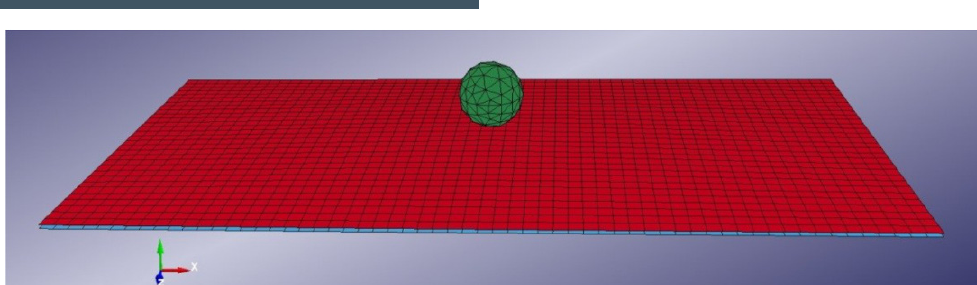
Figure 2. LS-DYNA model of a laminated composite plate and impactor.